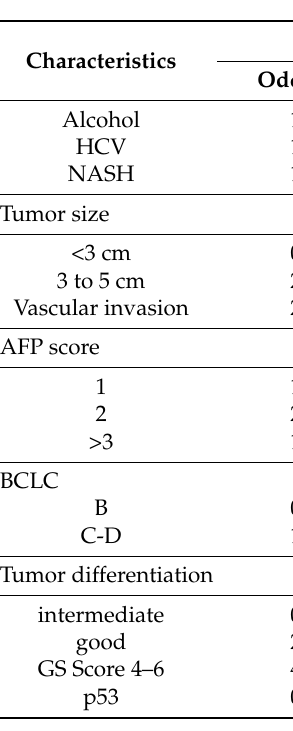
Table 3. hPG 80 and AFP levels odds ratio